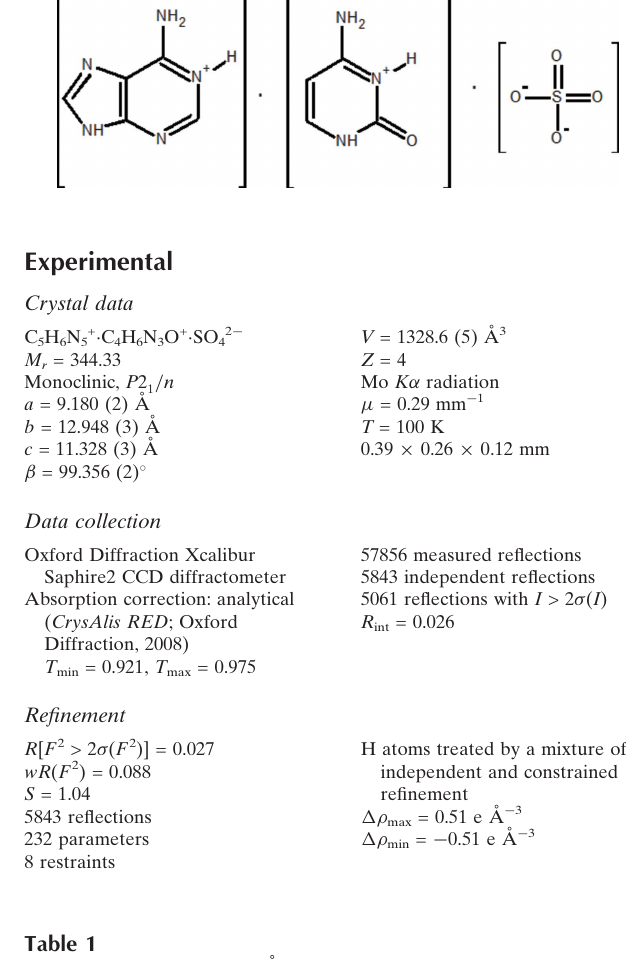
Hydrogen-bond geometry (A˚ , (cid:4)